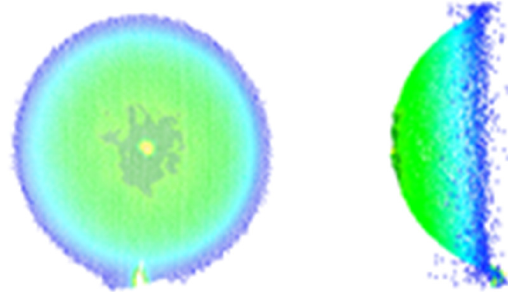
Figure 2. Point cloud of spherical target.